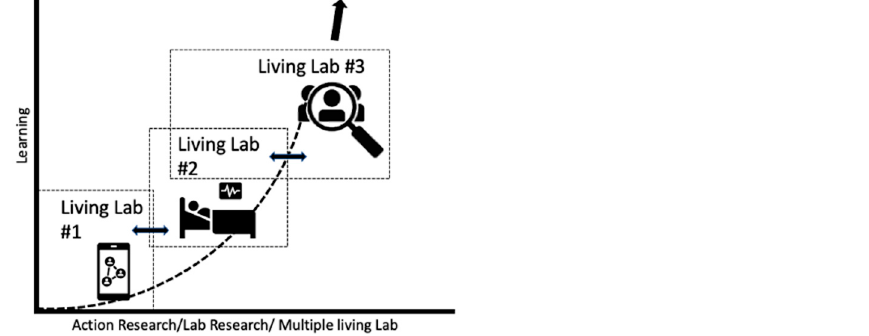
Figure 1. LLRA in Torino city. Multi-living lab and data interoperability: increase in knowledge.